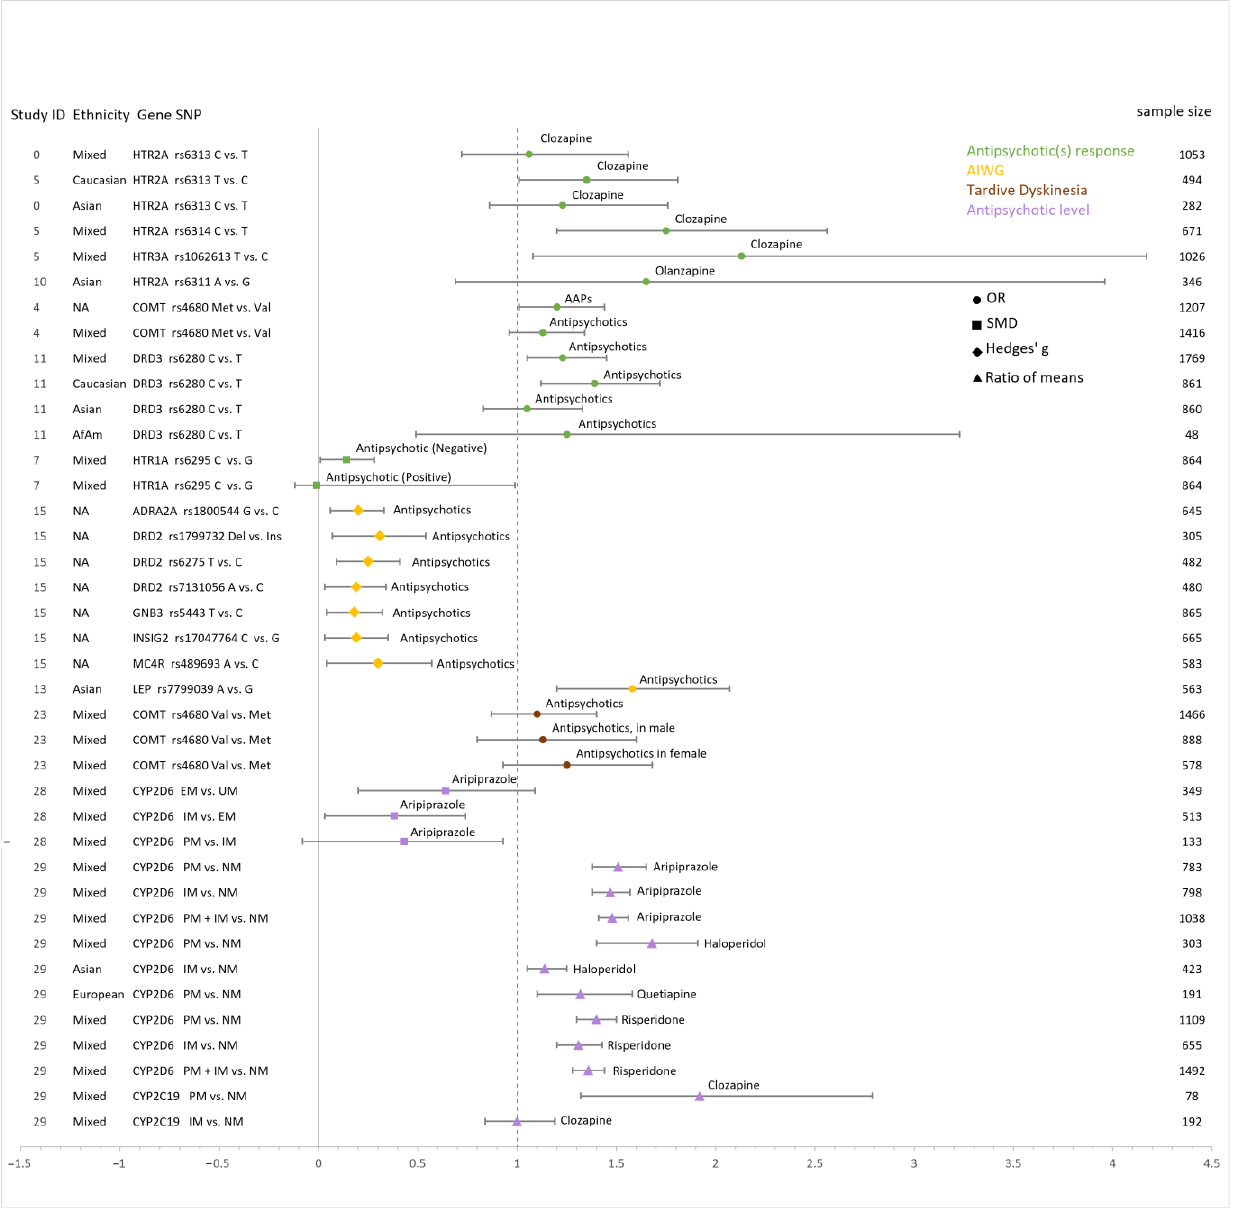
Figure 4. Pooled effect sizes of SNPs under the additive model. Footnote: Study ID is the same as the above figures. Study ID 0 represents the results recalculated in the present study by combining two or more meta-analyses. Each color of the marker in the middle of the error bar represents a different outcome. The shapes of markers mean different measurements of the effect size. Other significant SNPs without data under the additive model were not included in this figure. Abbreviation: AAPs, atypical antipsychotics; SMD, standardized mean difference; OR, odds ratio; AIWG, antipsychotic- induced weight